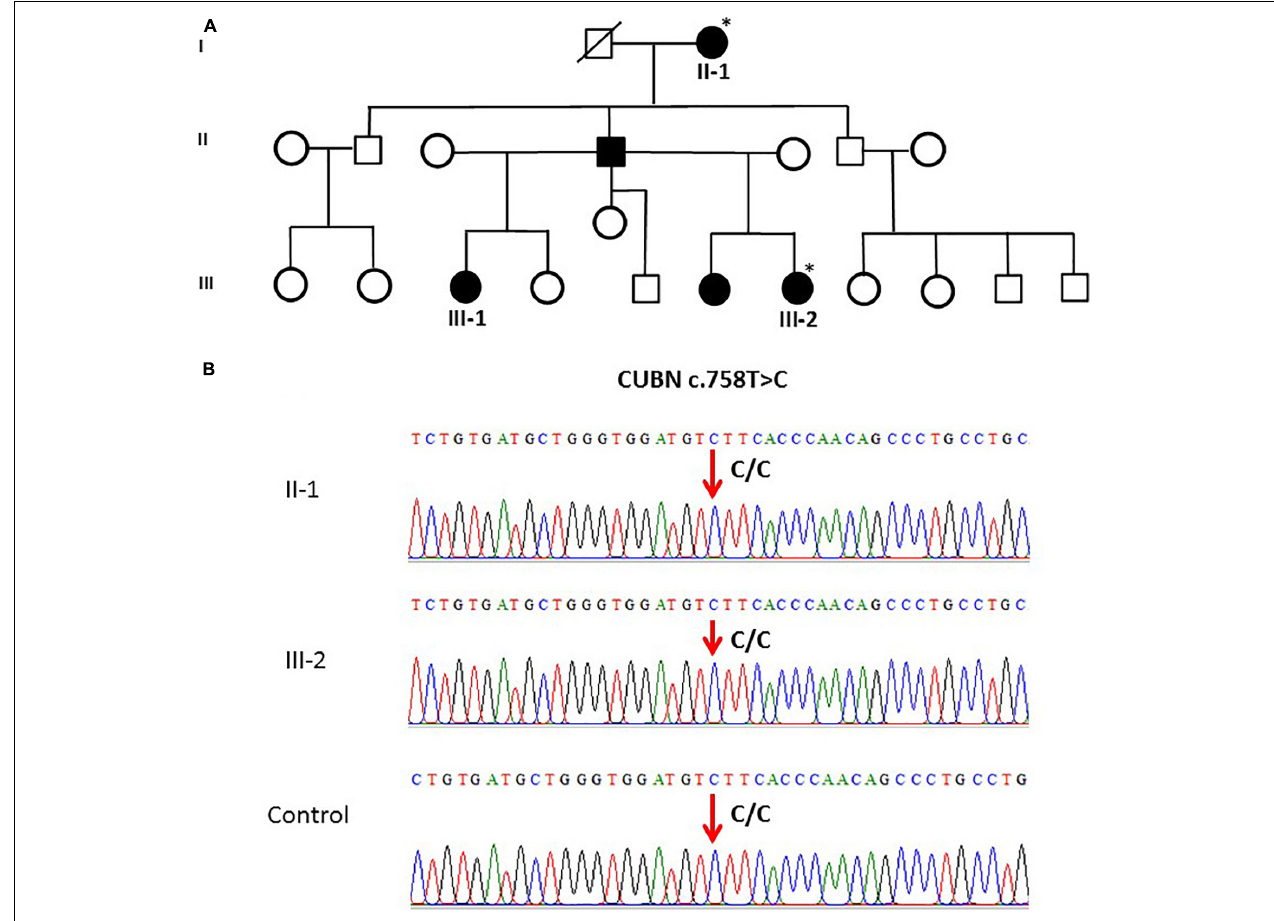
FIGURE 2 | (A) A pedigree for family 5, showing vitD-deficient II-1 and III-2 subjects. (B) Sanger sequencing chromatogram revealed c.758T > C polymorphism (homozygous CC genotype) in CUBN gene in members of family 5 and control. ∗ Samples